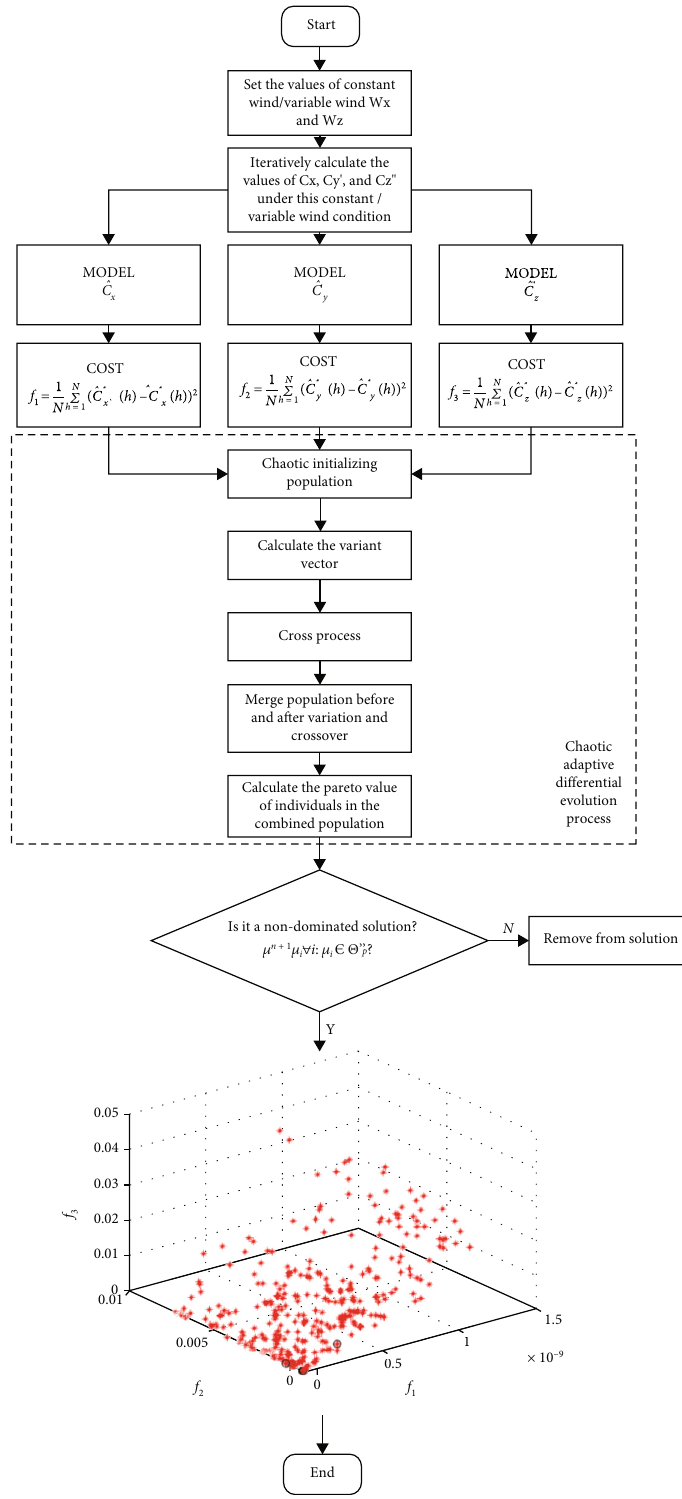
Figure 8: Wind velocity estimation